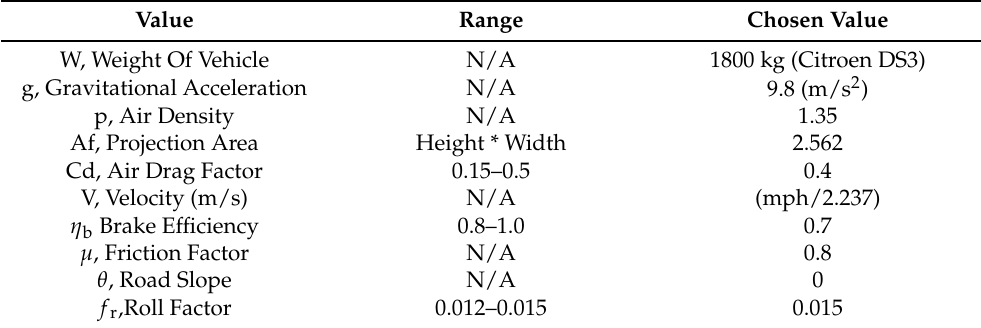
Table 2. Simulation parameters.